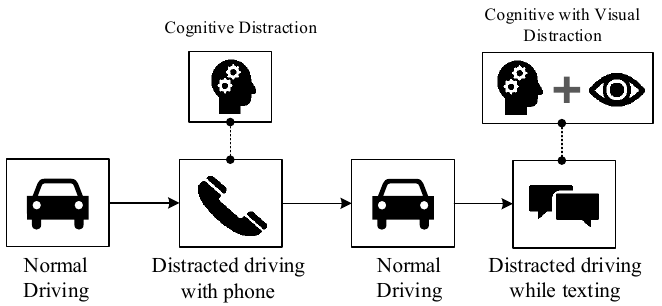
Figure 2. Experimental setup.